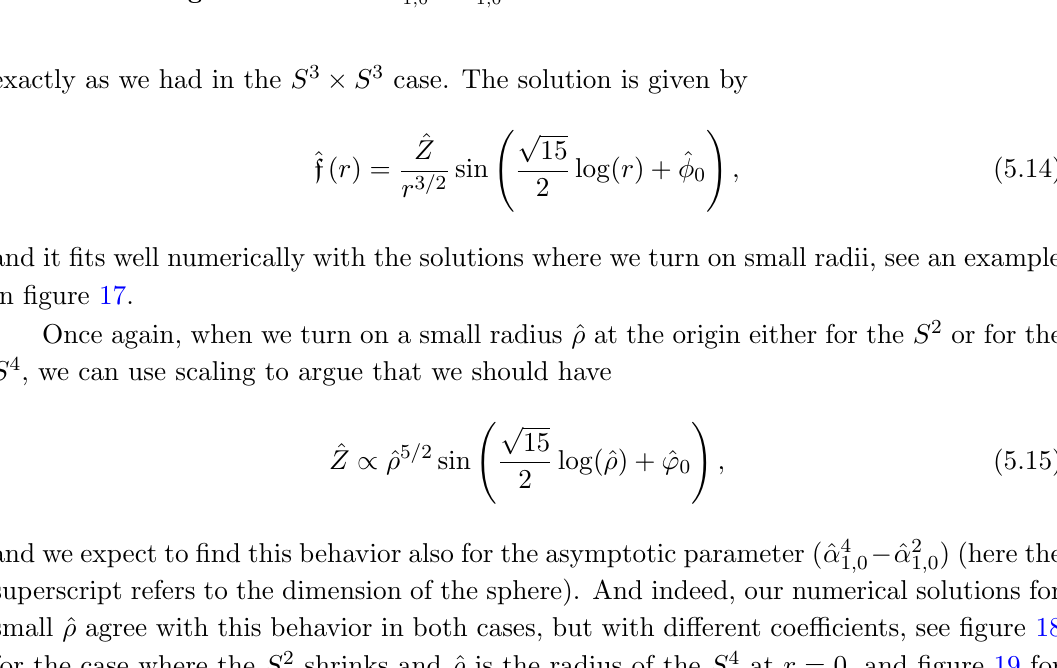
Figure 18 . A (cid:12)t of ^ (cid:11) 4